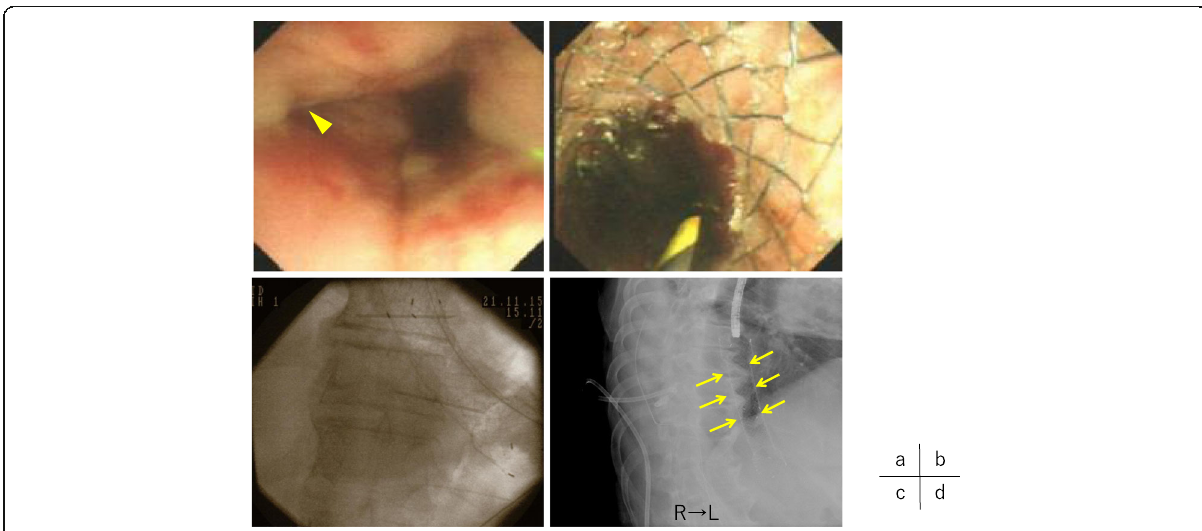
Fig. 2 Esophageal stent placement. a Endoscopy revealed a pinhole perforation in the left posterolateral wall of the lower esophagus (arrowhead). b – d Esophageal stent placement (arrows) ( b endoscopy, c fluoroscopy, and d chest